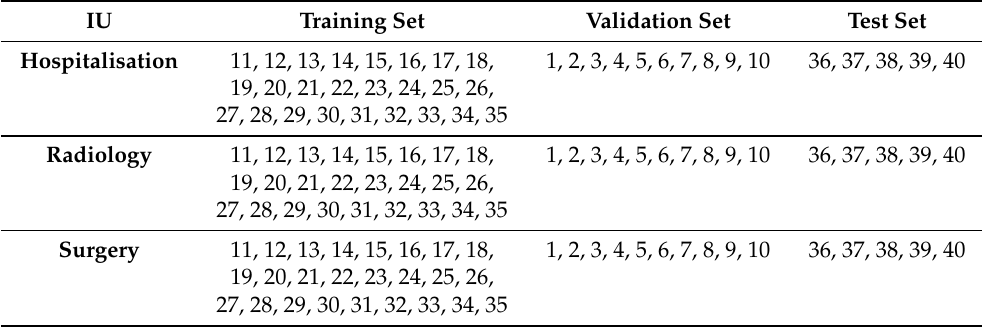
Table 3. Selection of the training set, validation set and test set for the first version of the Detectron2 model (3 IUs).